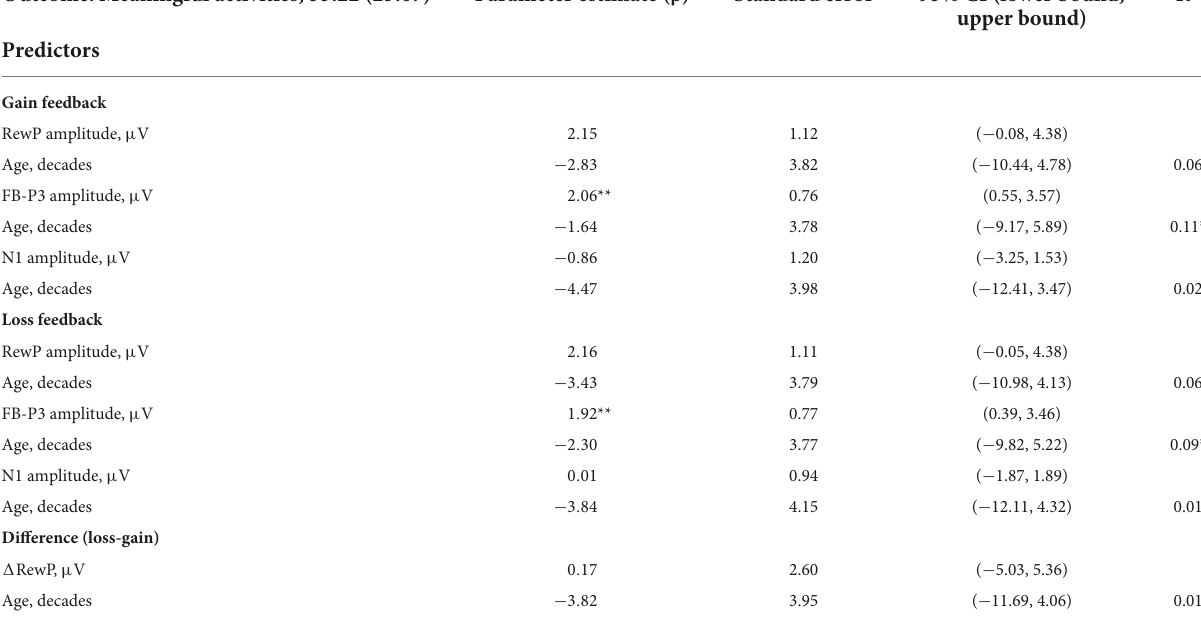
TABLE 2 Multiple linear regressions predicting real-world motivation (meaningful activities). Outcome: Meaningful activities, 33.22